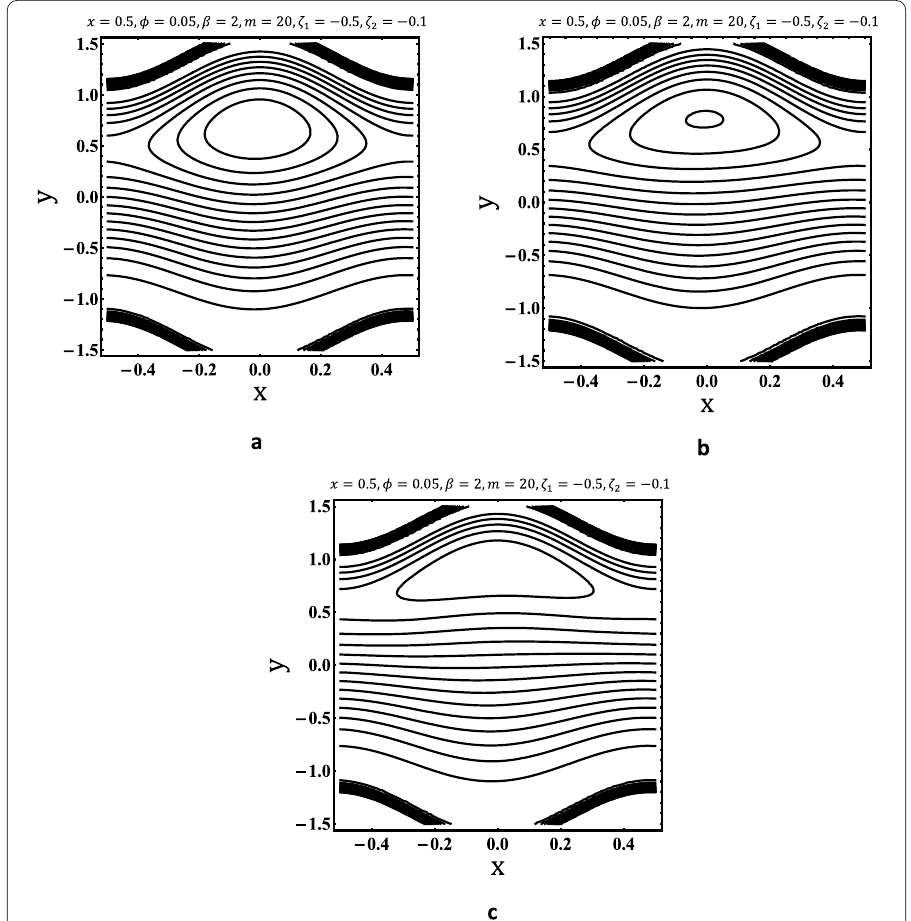
Figure 4 Streamline distribution for; ( a ) H r = 0.0, ( b ) H r = 1.5, and ( c ) H r =